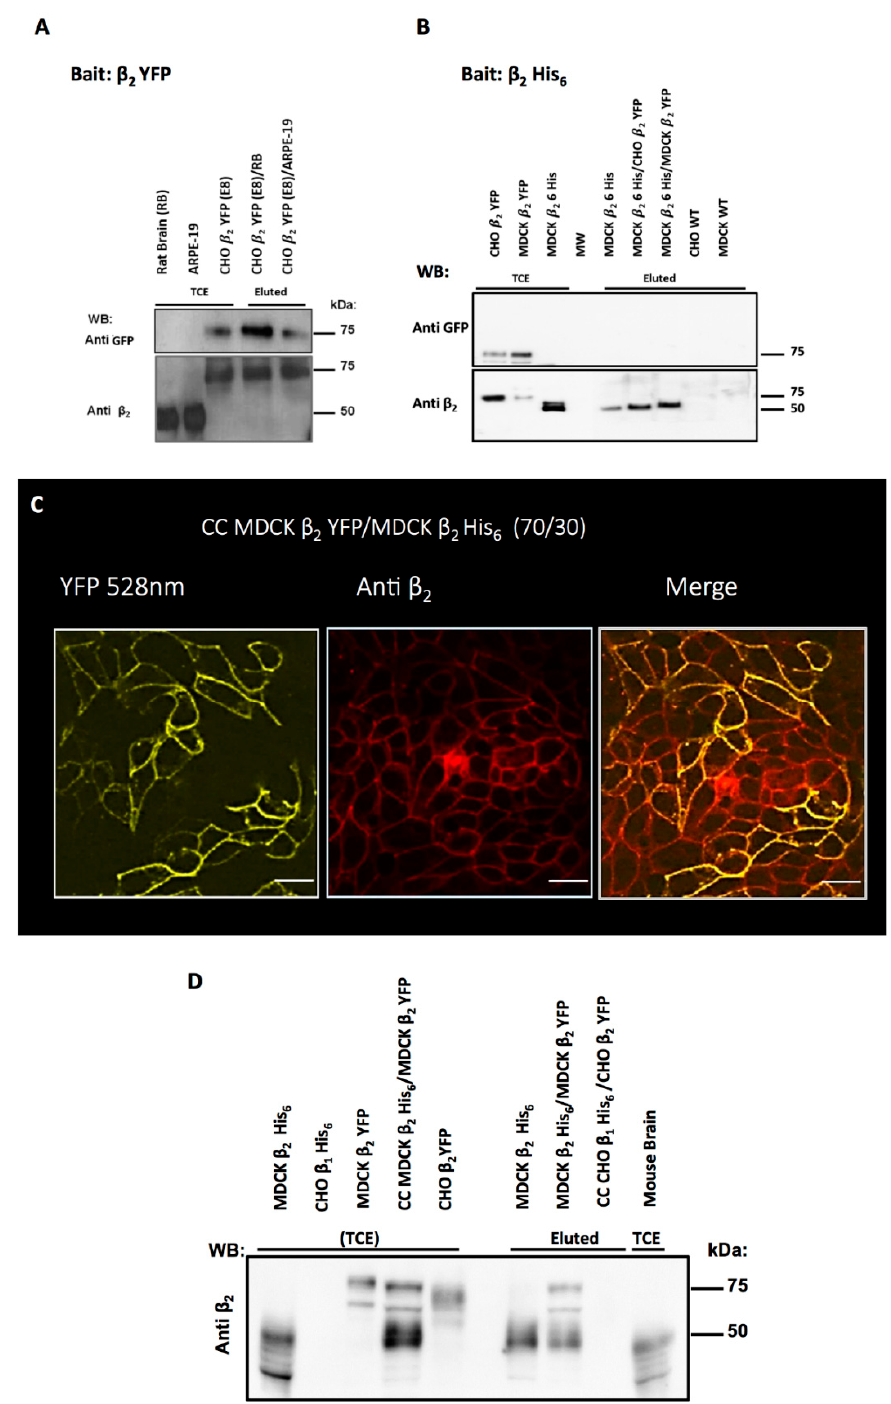
Figure 6. Protein–protein interaction analyses of β 2 subunit. ( A ) For pull-down assay, β 2 YFP was immobilized on GFP-sepharose beads (bait). Then, the lysate of rat brain or ARPE-19 cells expressing β 2 subunit (prey) were incubated to form β 2 – β 2 complexes. Western blot analysis shows the expression of β 2 subunit in ARPE-19 cells and rat brain extract (TCE—Total Cell Extract). Both anti-GFP and anti- β 2 antibodies detect the β 2 subunit in CHO β 2 YFP cells. Nevertheless, none of the assayed β 2 subunits were pulled down by immobilized β 2 YFP. ( B ) A pull-down assay using β 2 His 6 as bait, immobilized on Ni-NTA HF resin. Total extracts of CHO β 2 YFP and MDCK β 2 YFP cells (prey) were incubated to form β 2 – β 2 complexes. WB analysis shows the expression of β 2 subunits in all transfected cell lines. None of the prey proteins (tagged with YFP) appears to form β 2 – β 2 interac- tion (Eluted) on the Ni-NTA HF resin. ( C ) IF images of a co-culture of MDCK cells transfected with β 2 YFP or β 2 -His 6, in a 70/30 ratio. On the left panel, an image of cells expressing β 2 YFP are shown